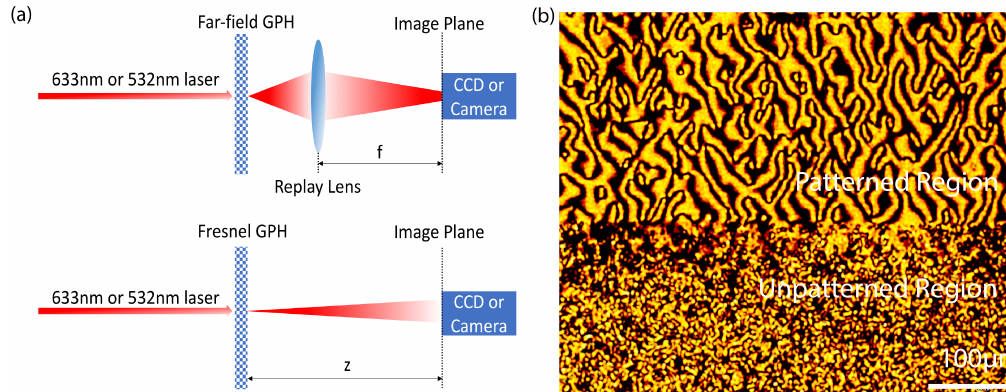
Figure 3. ( a ) Illustration of the characterization setups; ( b ) micrograph at the edge of a far-field liquid crystal geometric-phase hologram (GPH) with a 5- µ m pixel size, between crossed